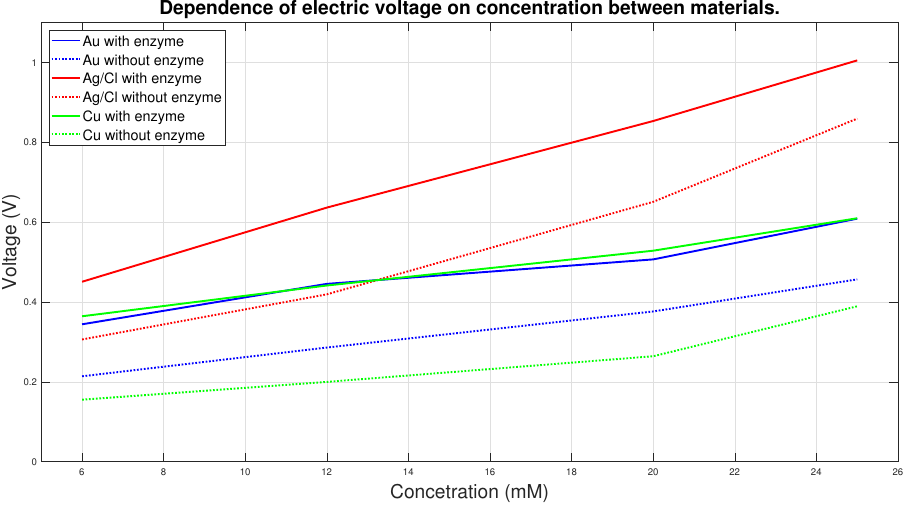
Figure 11. Dependence of electric voltage on concentration between materials.